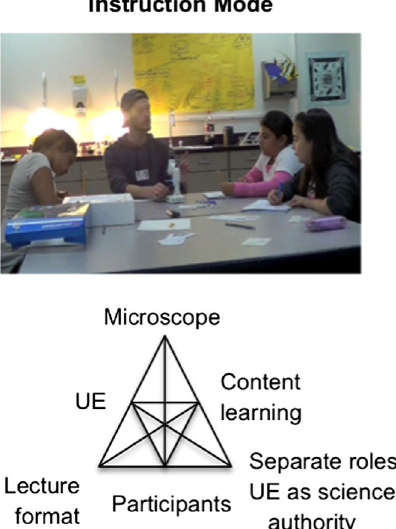
FIG. 2. Instruction mode. Photo (top) shows Michael and his student group working on a microscope activity during a PISEC session. The triangle (bottom) shows the interconnected aspects of the activity system where Michael is the